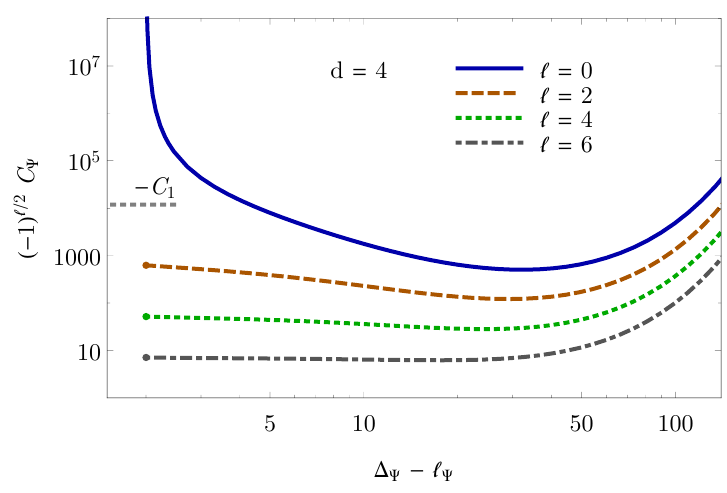
Figure 3 . Numerical value of the coe(cid:14)cient C (cid:9) of eq. (2.20) in d = 4 as a function of the scaling dimension (cid:1) (cid:9) and spin ‘ (cid:9) of the intermediate operator (cid:9). The value of the universal contribution C 1 is shown as well for